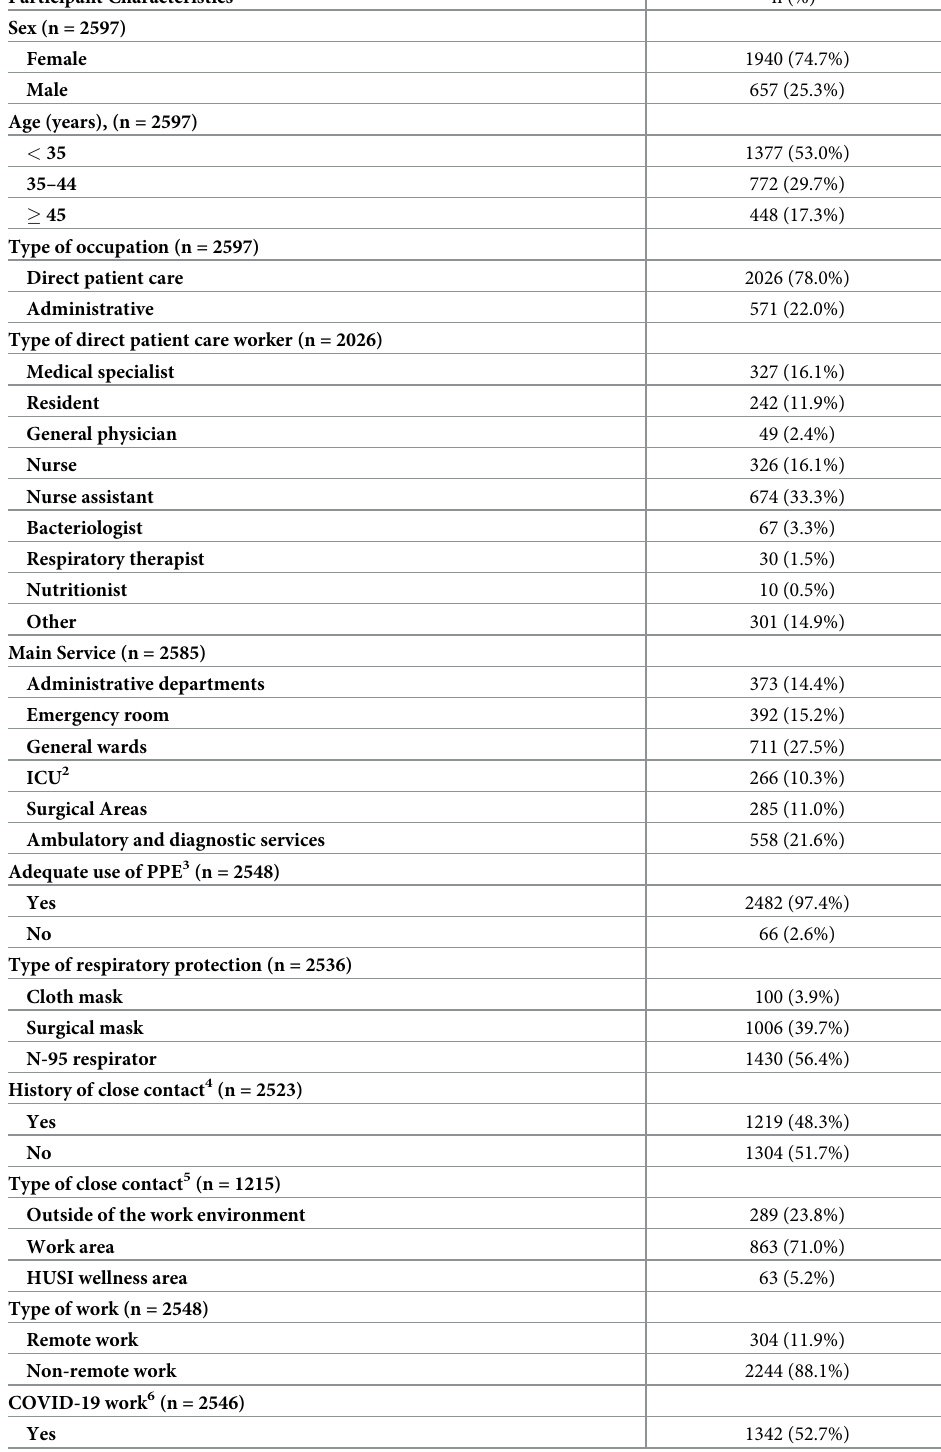
Table 1. Characteristics of the study population in Hospital Universitario San Ignacio (Retrospective cohort and seroprevalence study). March 6, 2020 to February 12,